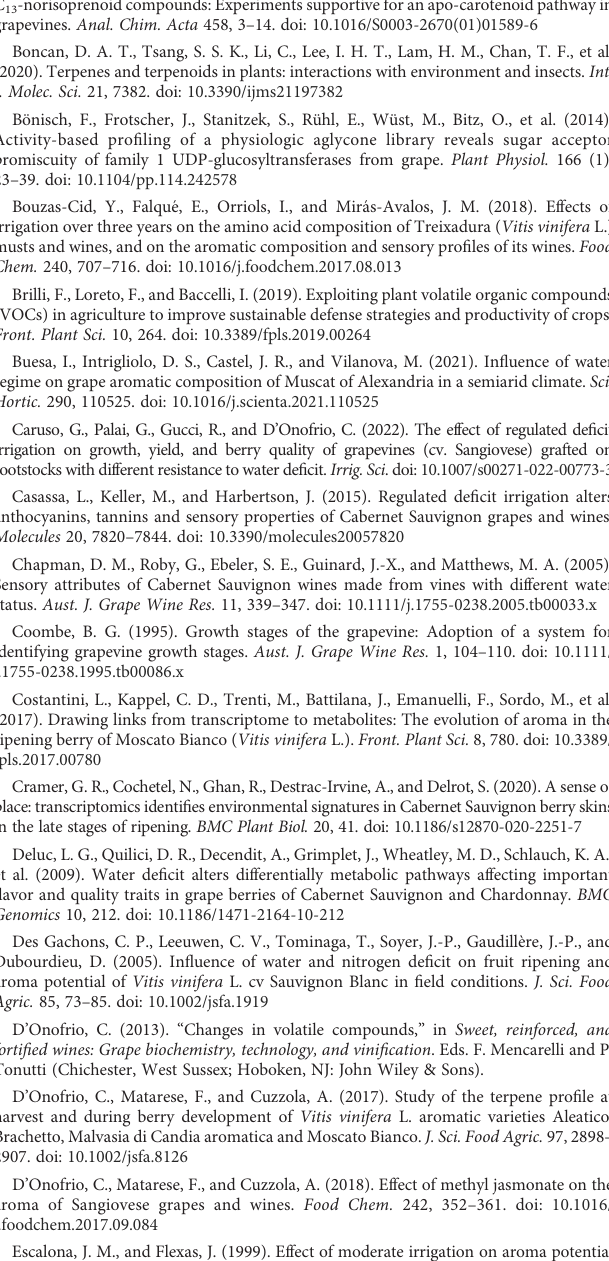
SUPPLEMENTARY TABLE 1 Correlation coef fi cients between free monoterpenes, glycosylated monoterpenes, monoterpenes regulators genes and the relative expression of monoterpenes synthases within all irrigation treatments in 2020 year. SUPPLEMENTARY TABLE 2 P-values of correlation probability between free monoterpenes, glycosylated monoterpenes, monoterpenes regulators genes and the relative expression of monoterpenes synthases within all irrigation treatments in 2020